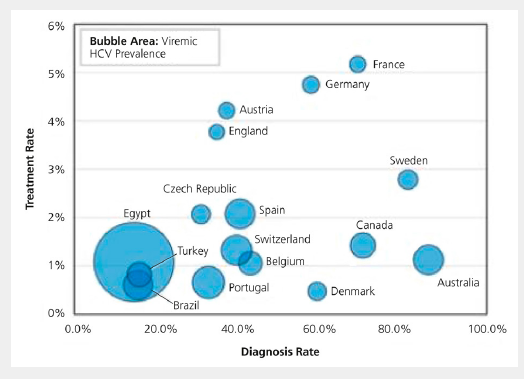
HCV prevalence, diagnosis and treatment rates in 2013 (from: Dore GJ, Ward J, Thursz M. Hepatitis C disease burden and strategies to manage the burden. J Viral Hepat. 2014;21(Suppl 1):1–4, reprint with permission from John Wiley and